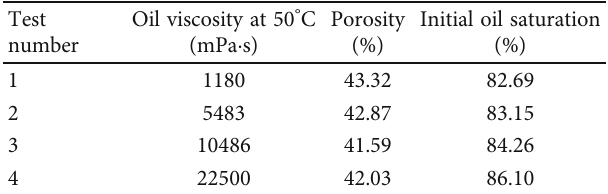
Table 2: Experimental